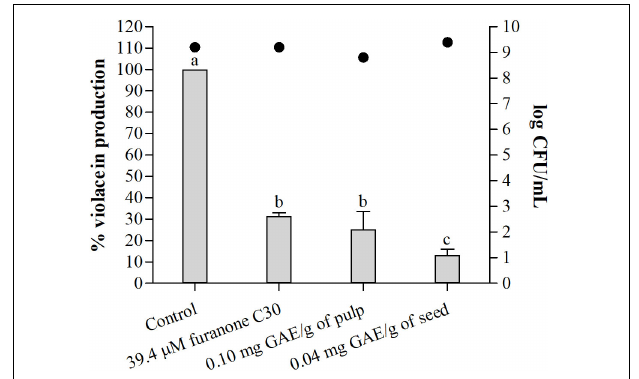
FIGURE 3 | Percentage (%) of violacein production by C. violaceum ATCC 12472 in absence and presence of furanone C30, sub-MIC of pulp, and seed phenolic extracts of S. cumini (L.) Skeels. Bars represent % violacein production and points represent bacterial population in log CFU/mL. Means followed by different letters differ statistically ( p <